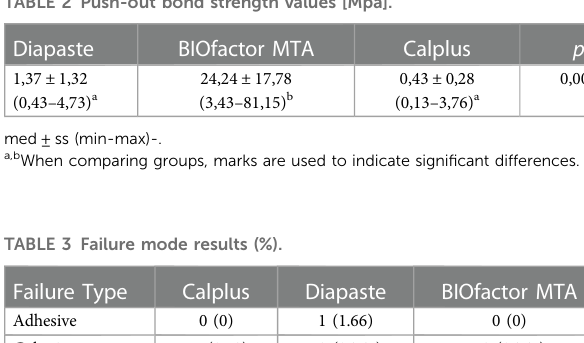
TABLE 2 Push-out bond strength values